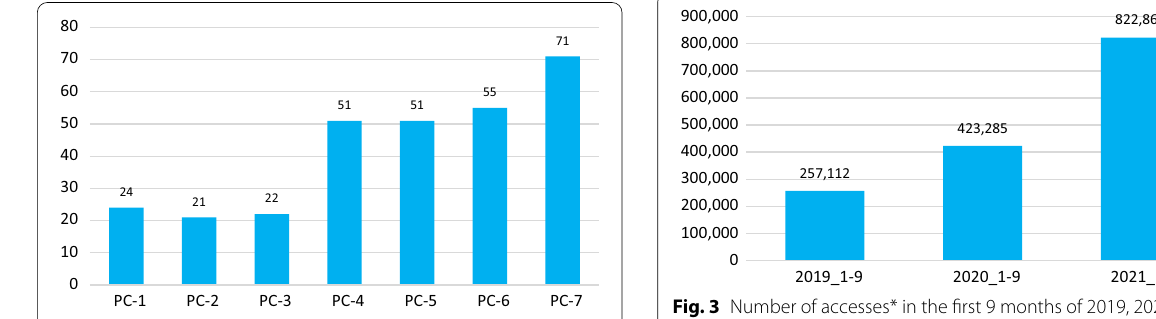
Fig. 1 Number of articles by publication cycle year